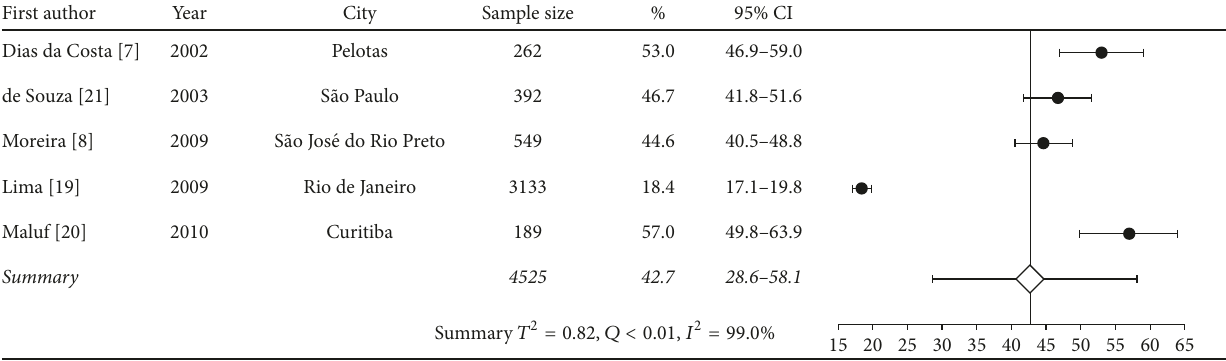
Figure 2: Meta-analysis of proportion of use of one BPLM (in chronological order according to the data collection year).